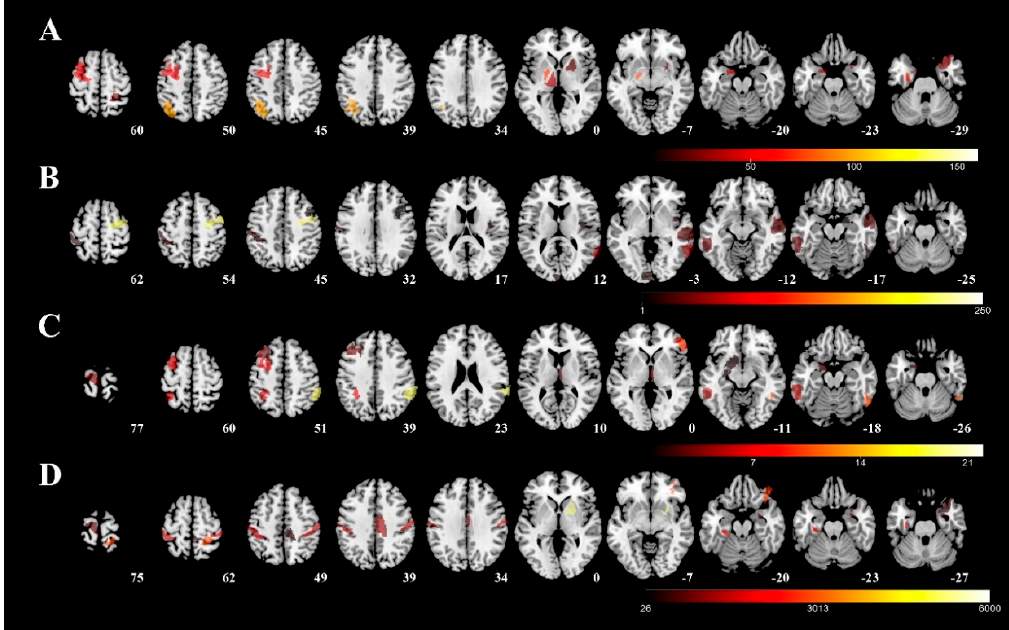
Figure 3 . Predictive regions visualized using 3D rendering. The predictive regions for each severity measure were visualized using the unstandardized coefficient in the regression model and overlapped on a T1 template (average T1 scans obtained from 152 individuals examined in the Montreal Neurological Institute). Row ( A ): UPDRS-III; row ( B ): PIGD; row ( C ): MHY; row ( D ): LEDD. UPDRS-III, motor subscale of Unified Parkinson’s Disease Rating Scale; PIGD, postural instability and gait disorder staging; MHY, modified Hoehn and Yahr staging; LEDD, levodopa equivalent daily dose.